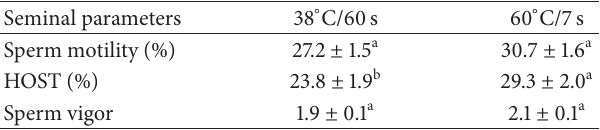
Table 5: Sperm motility, sperm vigor, and hypoosmotic swelling test (HOST) of thawed goat semen thawed at different temperatures (mean ± standard error of